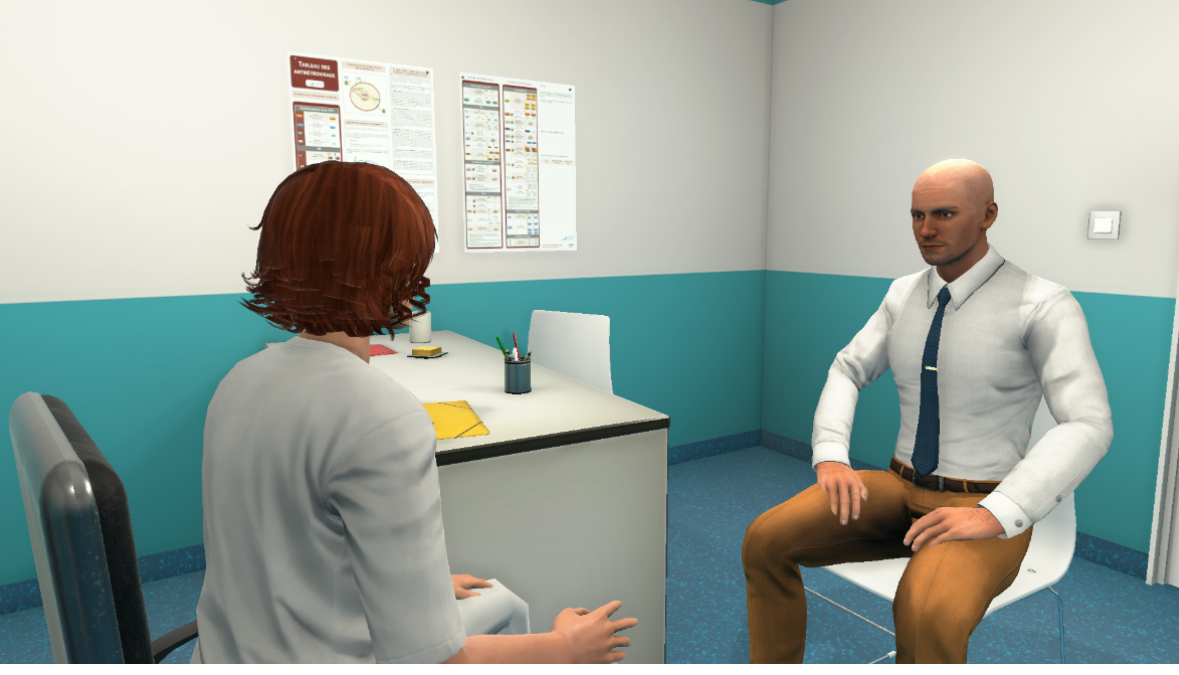
Figure 3. Mock-up of the virtual